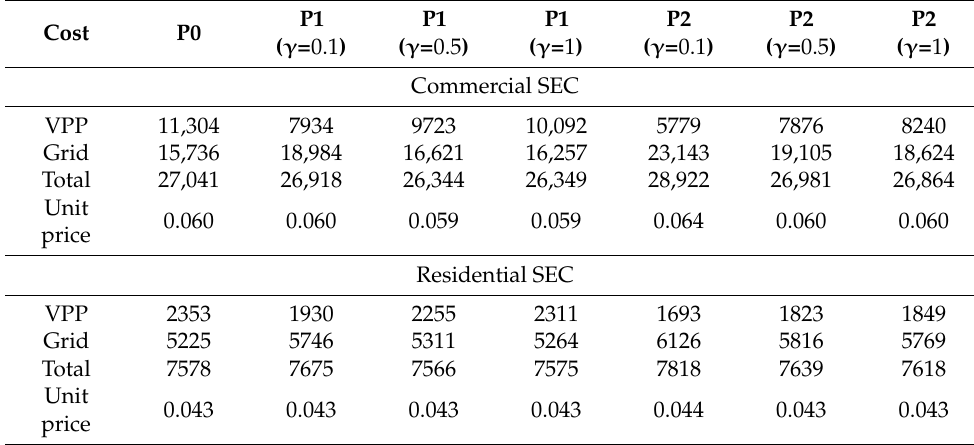
Table 4. Monthly costs according to VPP service ($/month).